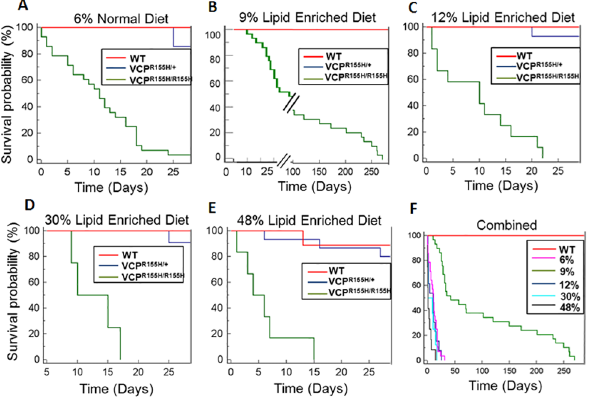
Fig 2. Survival curves of WT, VCP R155H/+ , and VCP R155H/R155H mice on normal and varying lipid- enriched diets. Kaplan-Meier survival probability (%) analysis for the WT, VCP R155H/+ , and VCP R155H/R155H pregnant dams placed on the (A) 6% normal diet, (B) 9% LED, (C) 12% LED, (D) 30% LED, and (E) 48% LED. (F) Combined survival curve of all the LED regimens for the WT, VCP R155H/+ , and VCP R155H/R155H . The number of mice analyzed per experiment is 35 – 40.